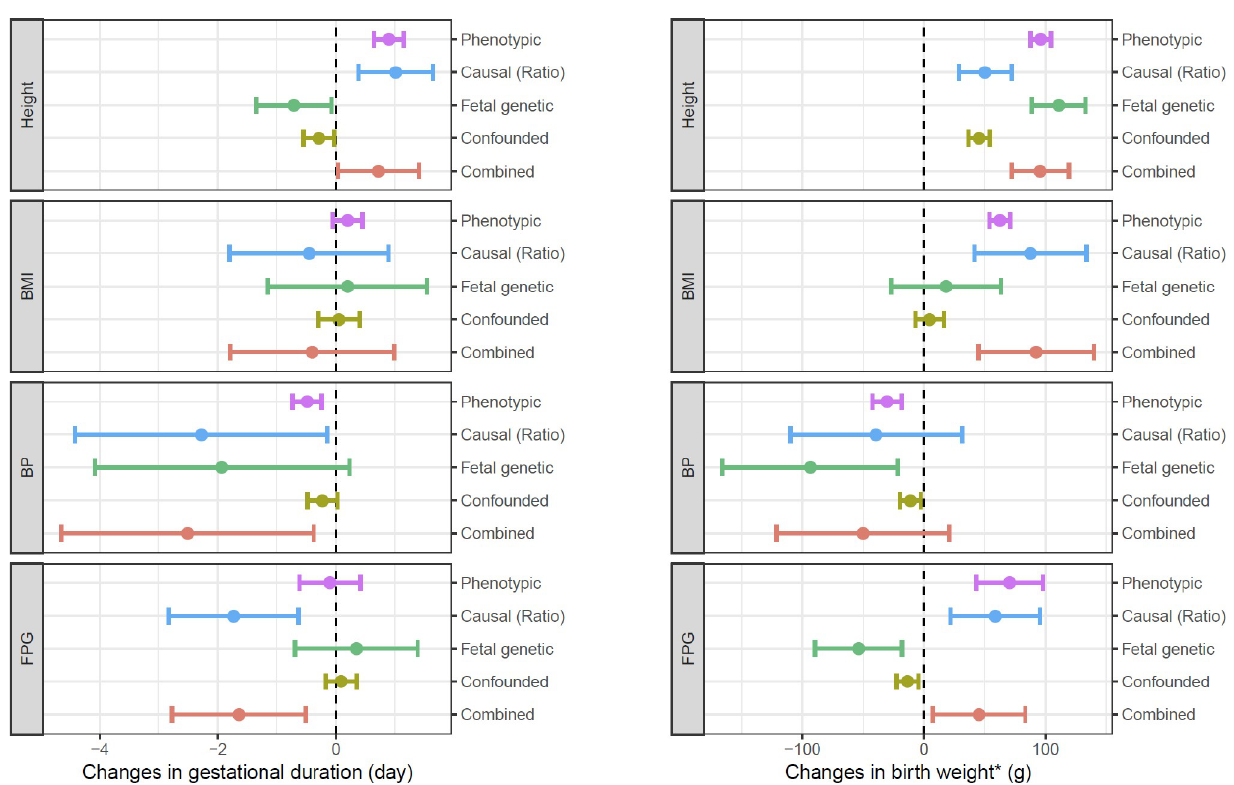
Fig 3. Observed phenotypic associations, estimated maternal causal effects, fetal genetic effects, and genetically confounded associations per 1-SD change in maternal traits on gestational duration (left) and birth weight (adjusted by gestational duration) (right). The 1-SD values for maternal traits are 6.4 cm (height), 4.0 kg/m 2 (BMI), 5.8 mmHg (BP), and 0.36 mmol/L (FPG). � indicates birth weight adjusted by gestational duration. BMI, body mass index; BP, blood pressure; FPG, fasting plasma glucose; SD, standard